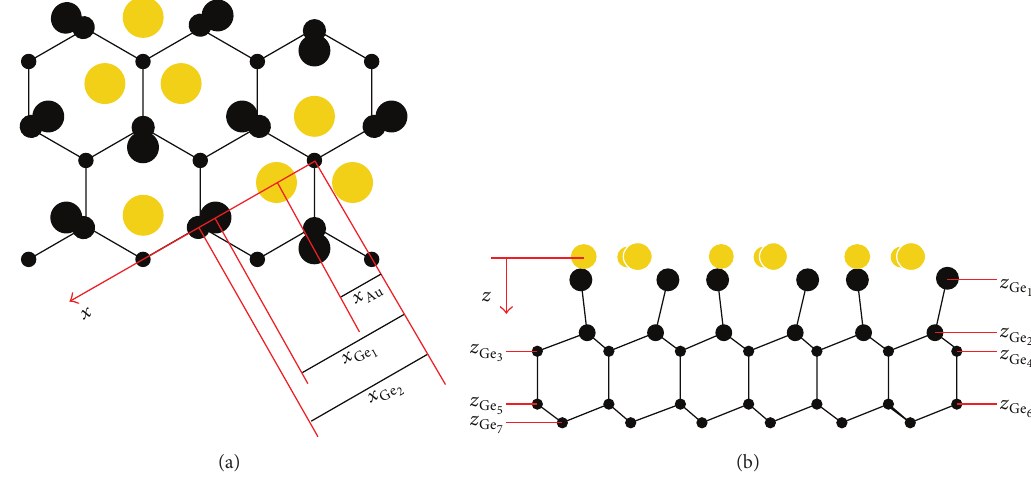
Figure 2: Top (a) and side (b) view of the CHCT model. The 𝑥 parameters have origin at the T 4 position; the 𝑧 parameters have their origin at the center of the Au